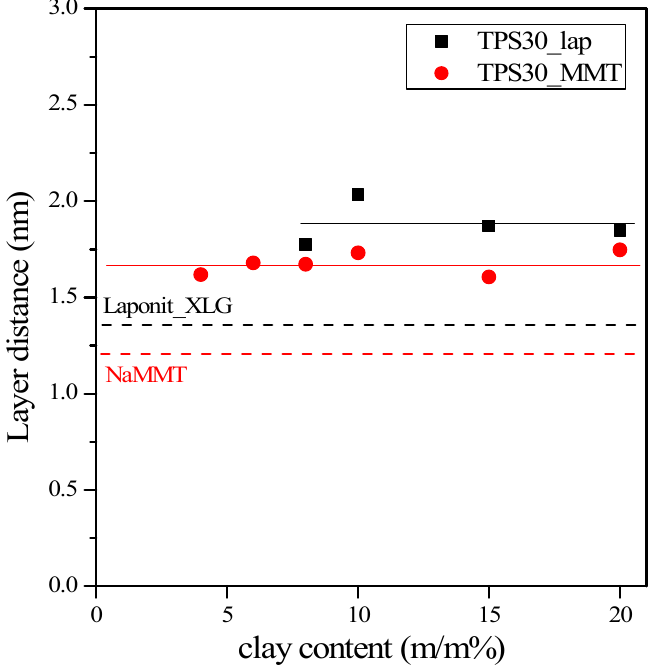
Figure 4. Dependence of the layer distance of silicates on the filler content in TPS30 nanocomposites. Although the diffraction peak of laponite is less intensive than that of montmorillonite, laponite XLG has a single diffraction peak at around 6.6 ◦ (Figure 3) [30] which shifts to smaller angles (4.8 ◦ ± 0.2 ◦ ) in some nanocomposites. This means that the original layer distance of laponite (1.33 nm) is increased to 1.88 ± 0.1 nm in the TPS nanocomposites (see Figure 4). Figure 3 also indicates that the peak corresponding to the laponite reflection is practically absent at 4% and 6% laponite contents and shifts toward smaller 2-theta